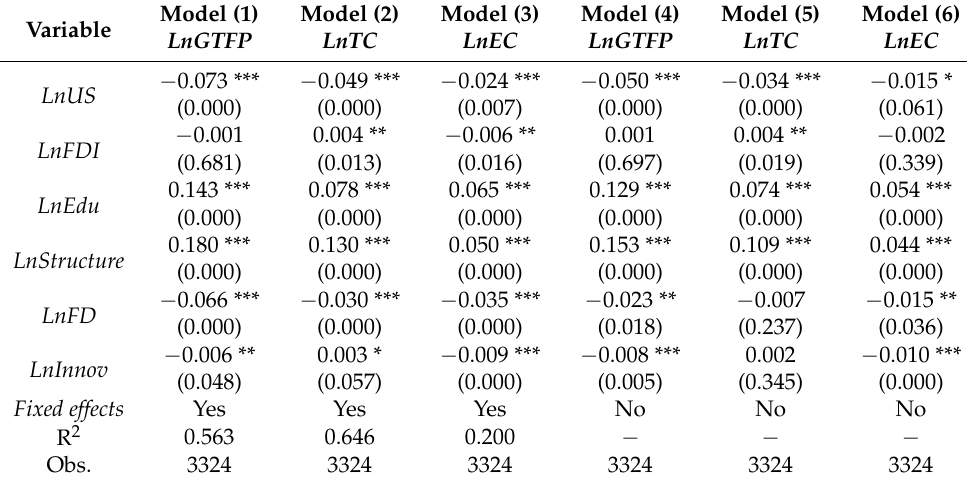
Table 3. Results of non-spatial panel data models (Key variable: US = sprawl level).